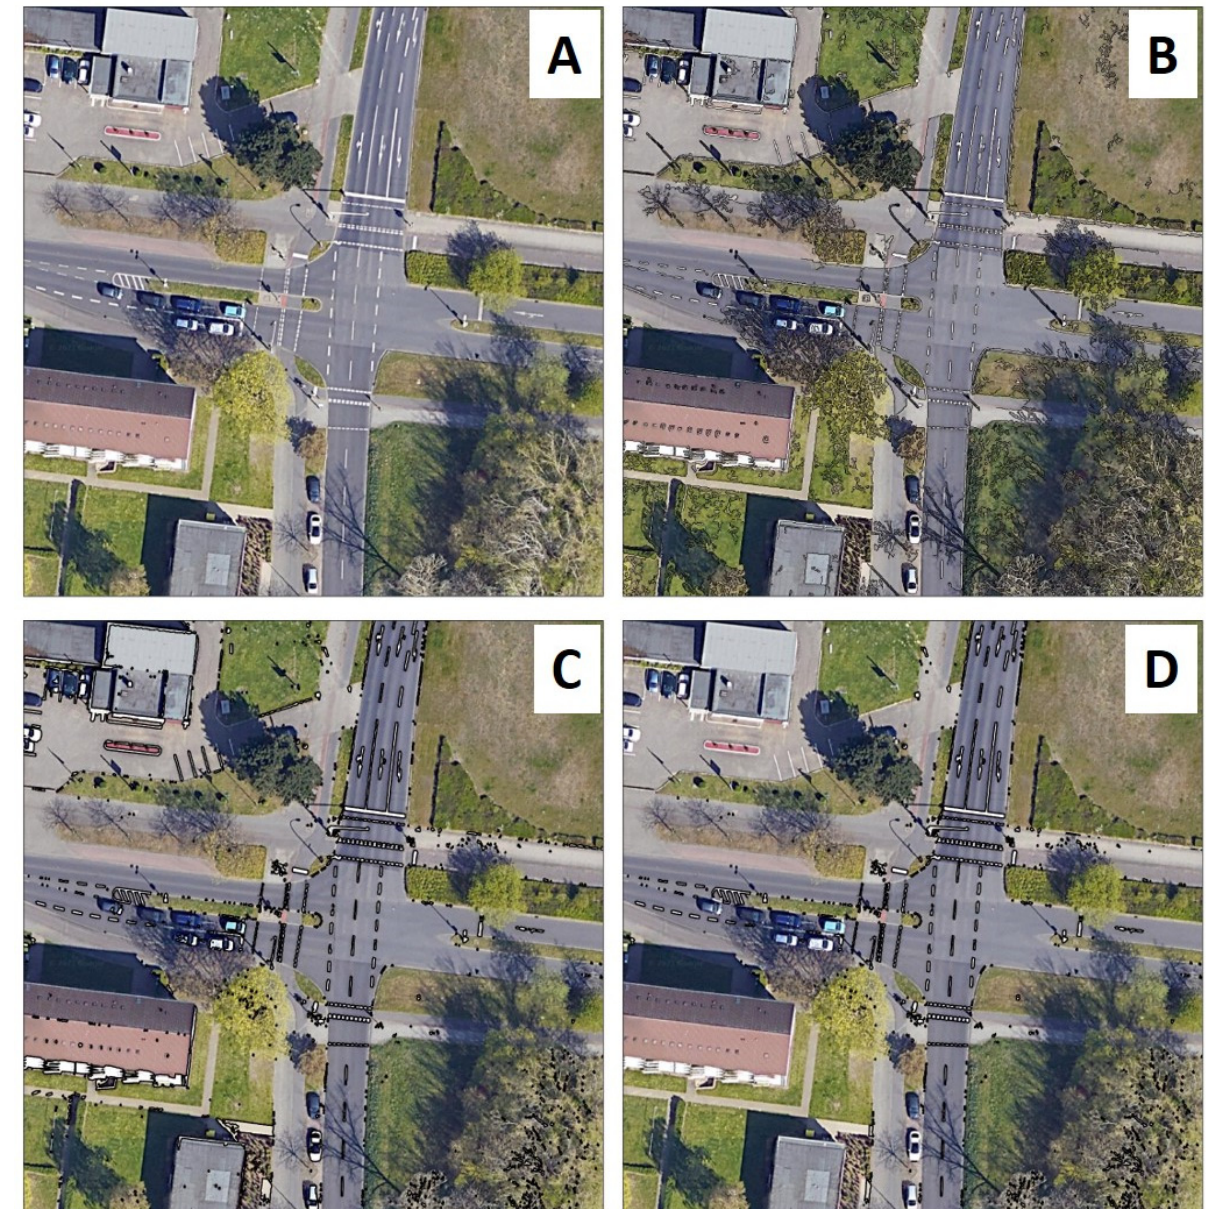
Figure 8. Stepwise process ( A – D ) of creating road marking samples with computer vision algorithms.